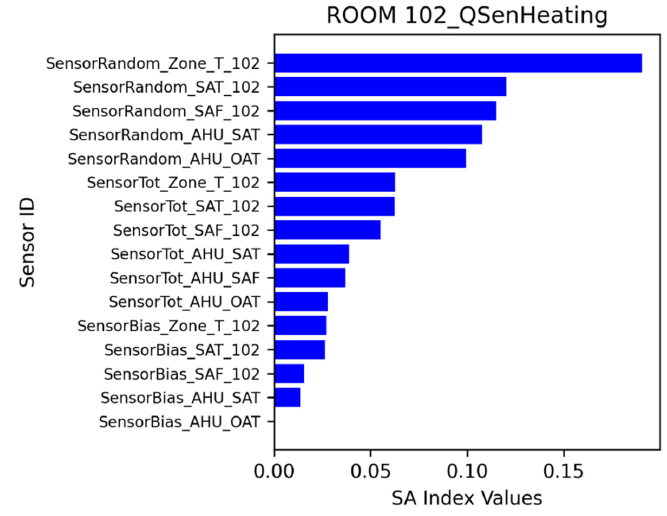
Figure 26. SA for zone 102 sensible heating energy.